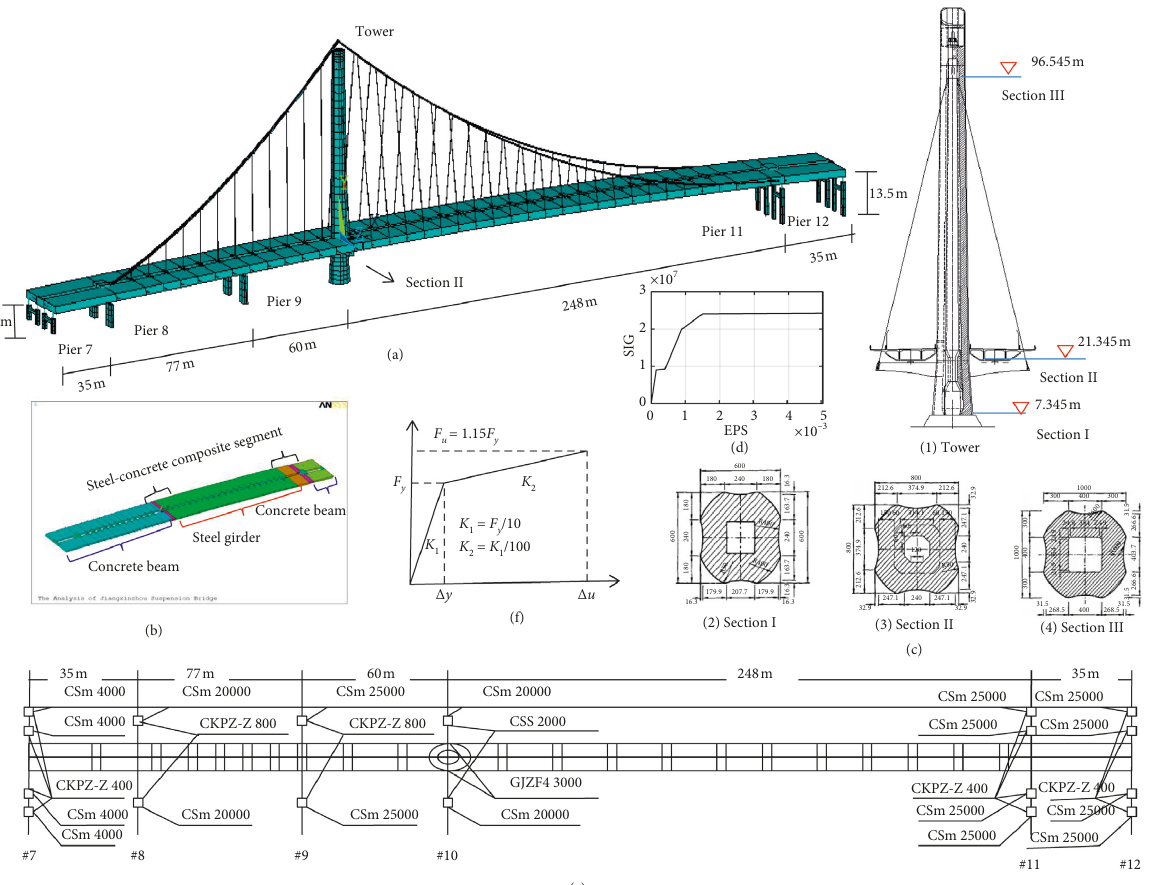
Figure 6: General configuration of the suspension bridge. (a) FE model of the bridge. (b) Modeling of the main girder. (c) Tower configuration and various sections. (d) Nonlinear model of the tower. (e) Bearing layout plan. (f) Nonlinear model of the elastic-plastic energy-dissipating